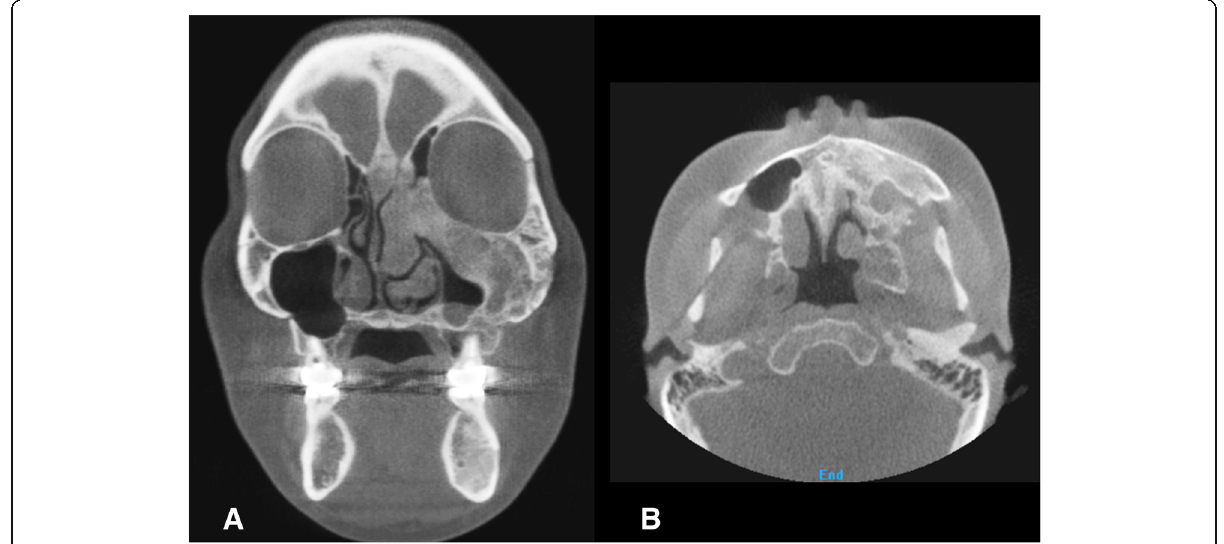
Fig. 5 3D CT image of coronal ( a ) and axial ( b ) view 4 years postoperative. No further expansion or re-growth of the dysplastic lesion was